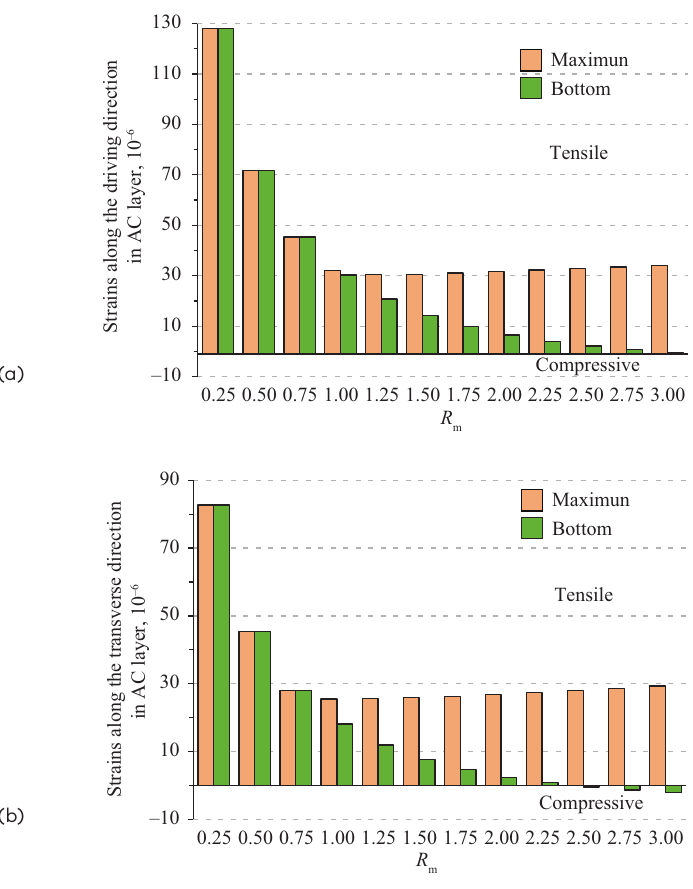
Figure 7. The horizontal maximum and bottom strains of the AC layer: (a) along the driving direction, (b) along the transverse